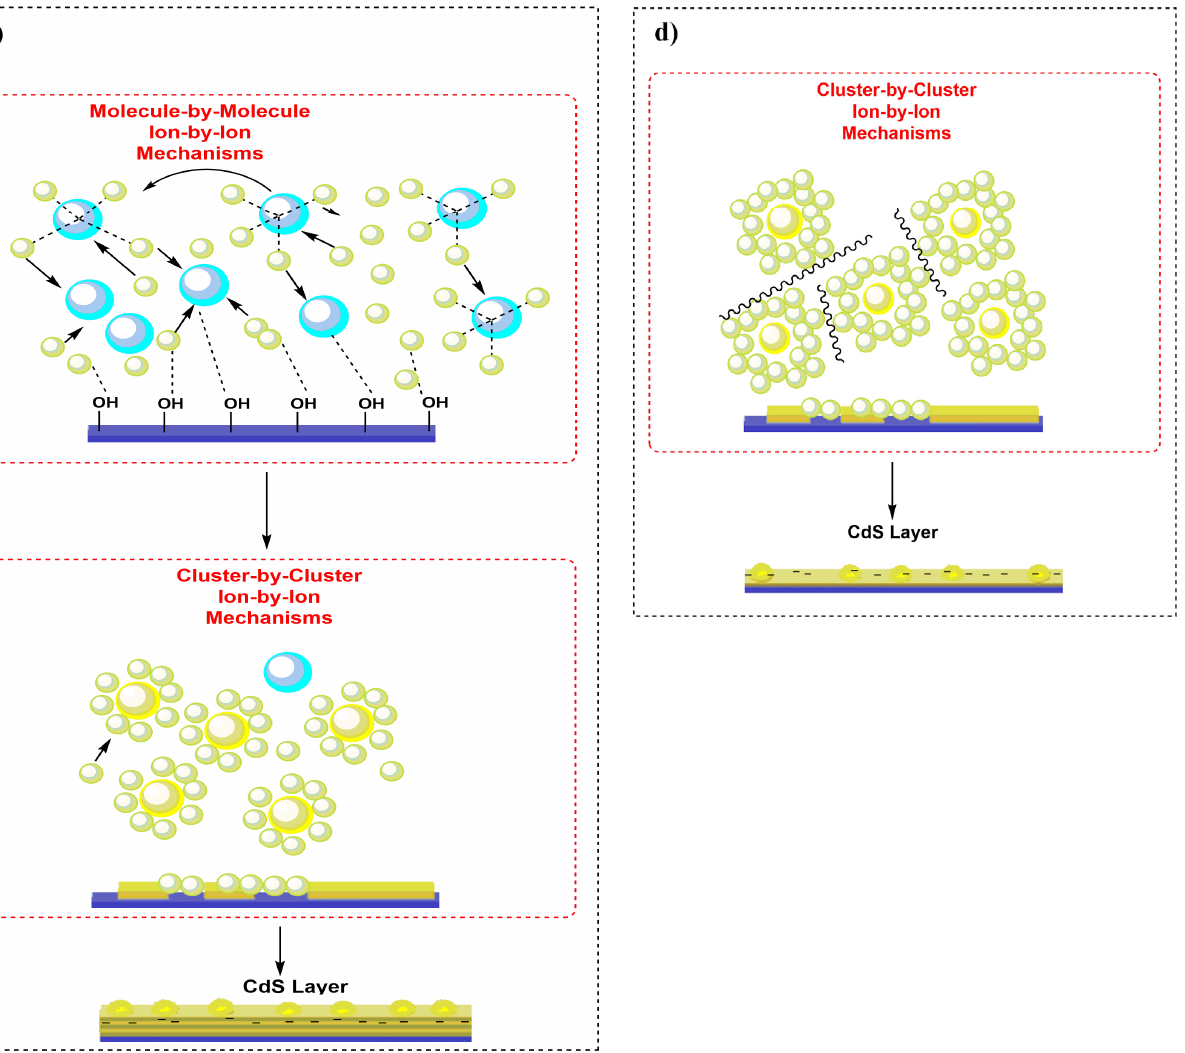
Figure 12. The formation of CdS for: ( a ) [1/0.75], ( b ) [1/1], ( c ) [1/5], and ( d ) [1/25].